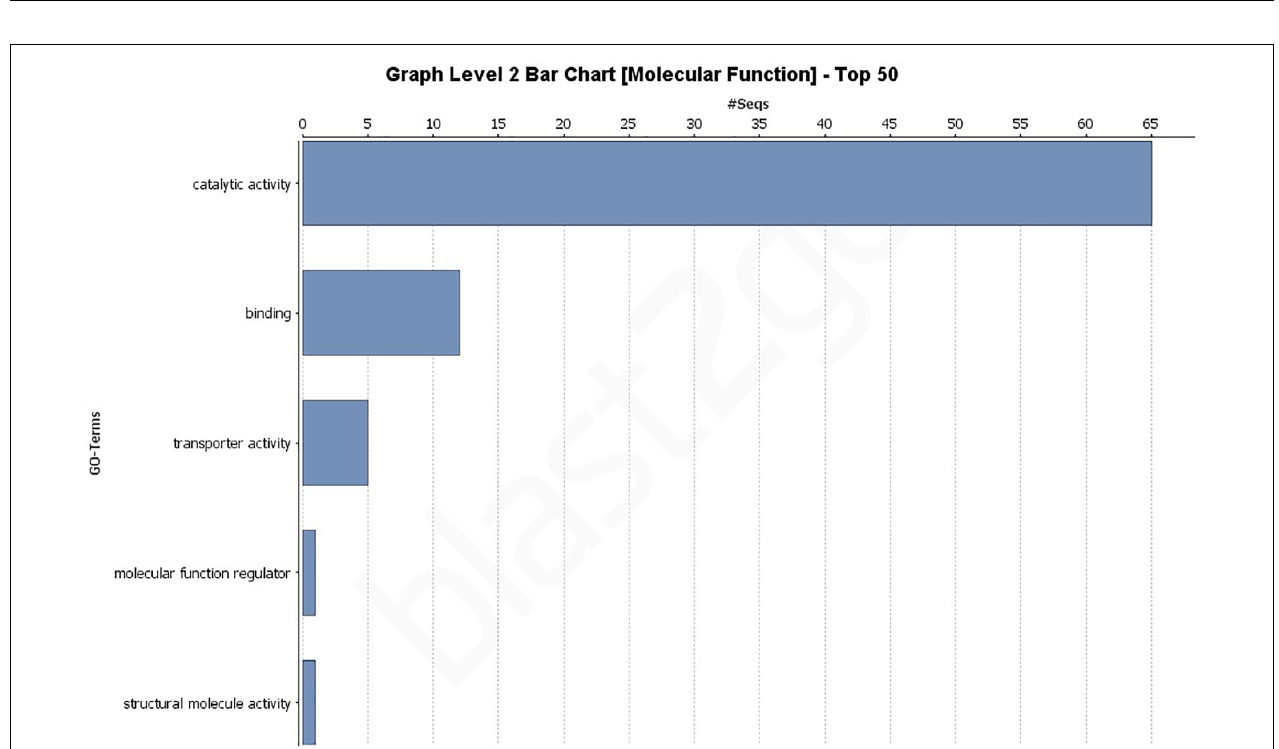
FIGURE 3 | Gene Ontology (GO) level 2 bar chart of the molecular function of all 193 effectors found across 18 genomes and the JR2 reference genome. See Supplementary Figure 2 for full network analysis of all 193 effectors.